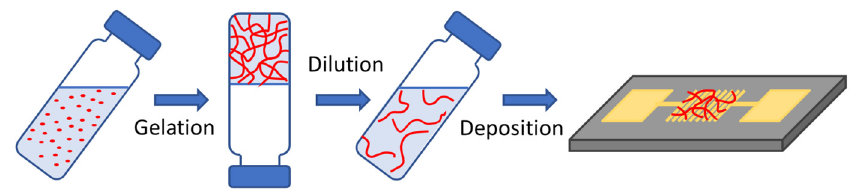
Figure 4. Schematic representation of the deposition process.